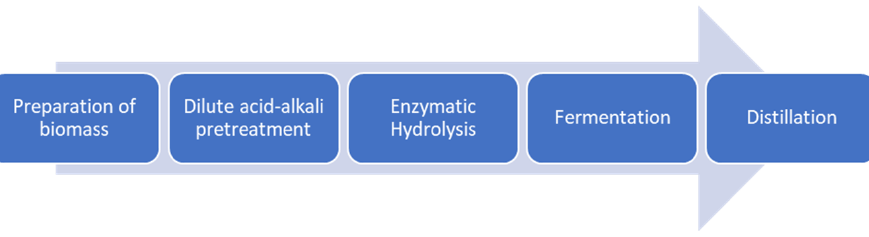
Figure 1. Bioethanol generation process from VG shoots.